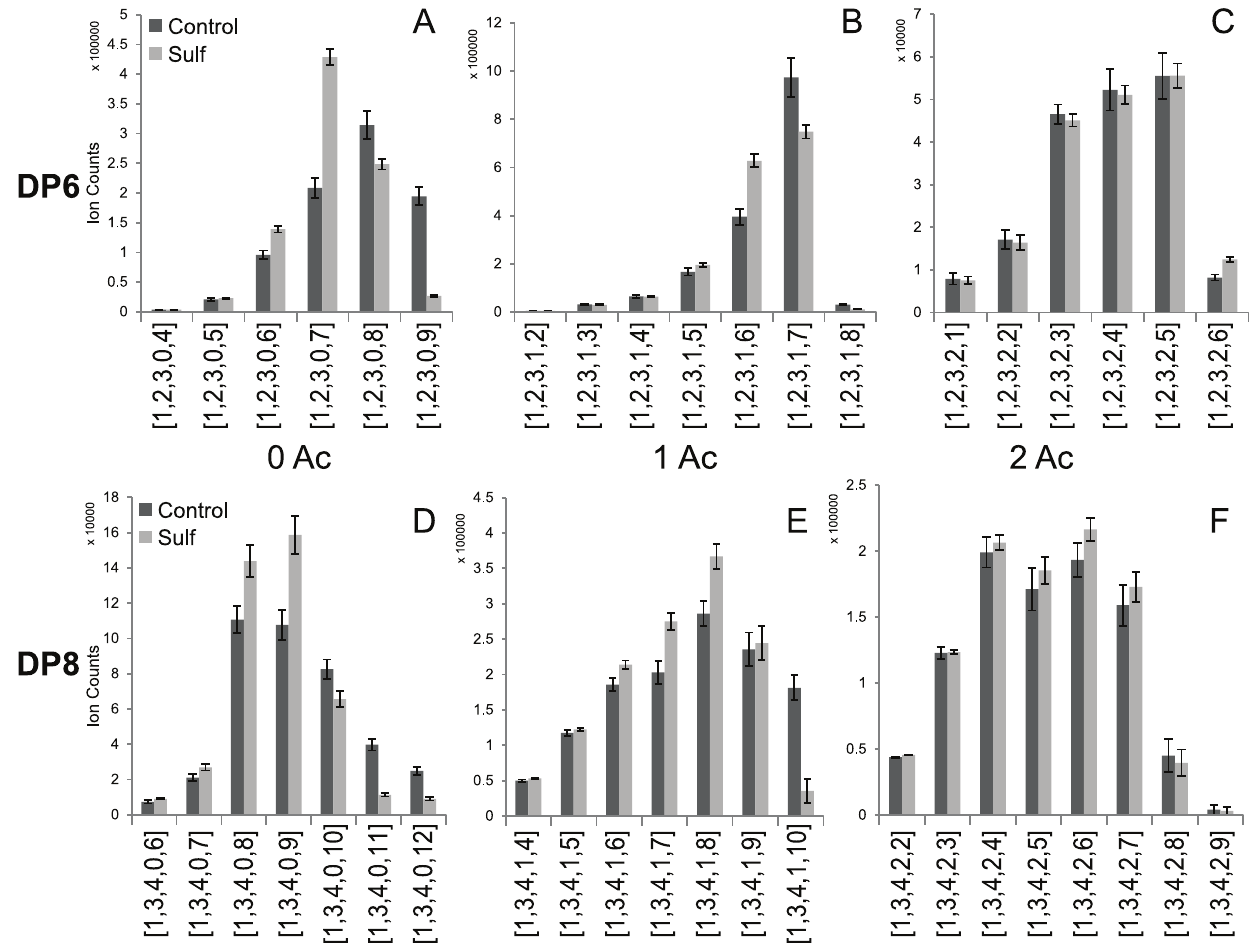
Figure 1. HS oligosaccharides composition profiles (from heparin lyase I digestion) before and after HSulf2 digestion. A, B and C show HS oligosaccharide DP6 with zero, one and two acetate groups separately. D, E and F show HS oligosaccharide DP8 with zero, one and two acetate groups separately. Error bar represents the standard deviation from triplicate LC-MS runs.